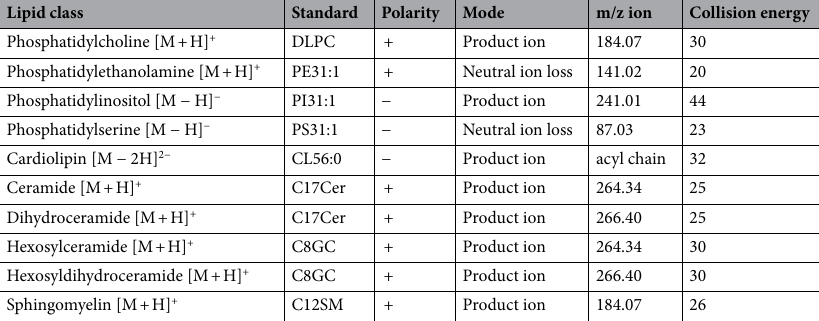
Table 2. MS detection conditions for the different lipid